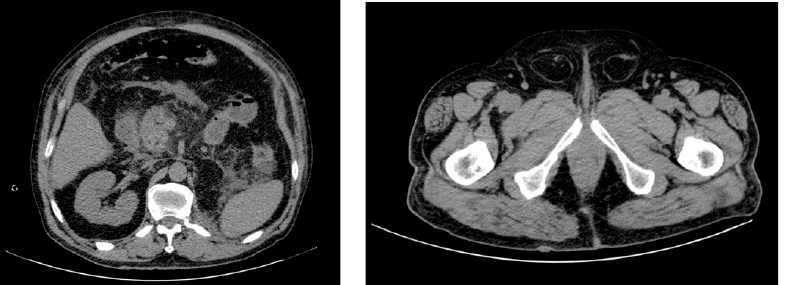
Figure 2. Computed tomography of the abdomen shows acute necrotizing pancreatitis complicated by abdominal compartment syndrome in a 76-year-old man; the round-belly sign and bilateral inguinal hernia can be observed.